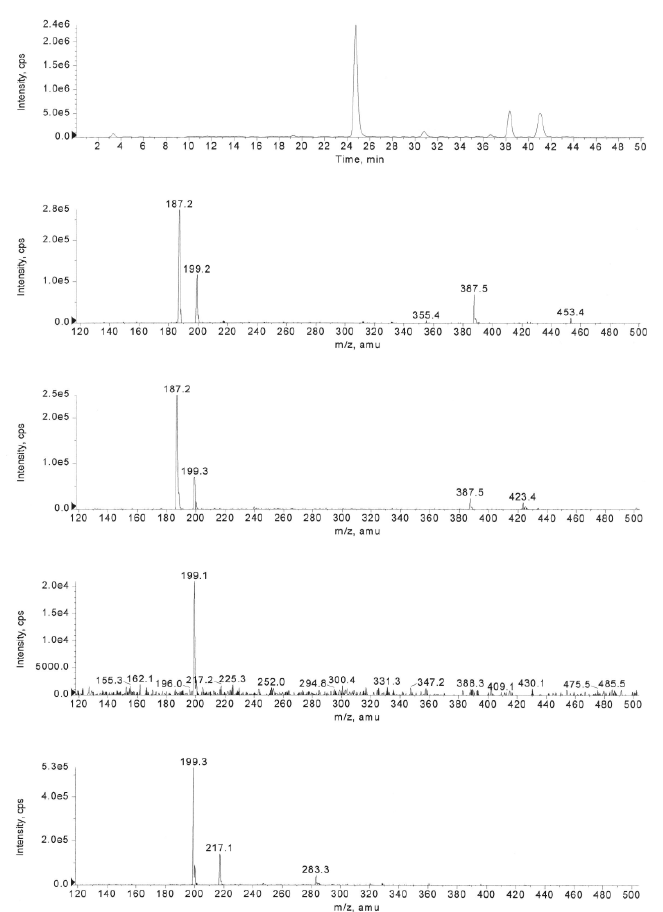
Figure 4. Inspection of mass spectra obtained from XIC m/z 217-218 (calcd. [M-H] - = 217.1) and 199-200 (calcd. [M-H] - = 199.1) for 19 , 20 and 21 during the hydrolysis of 1 (at t = 2 d) in the presence of GSH and HLE at pH 6.2 and 37 °C. Chromatographic conditions: A mixture of water and MeCN containing 0.1% formic acid (linear gradient from 1% up to 50.0% MeCN in 35